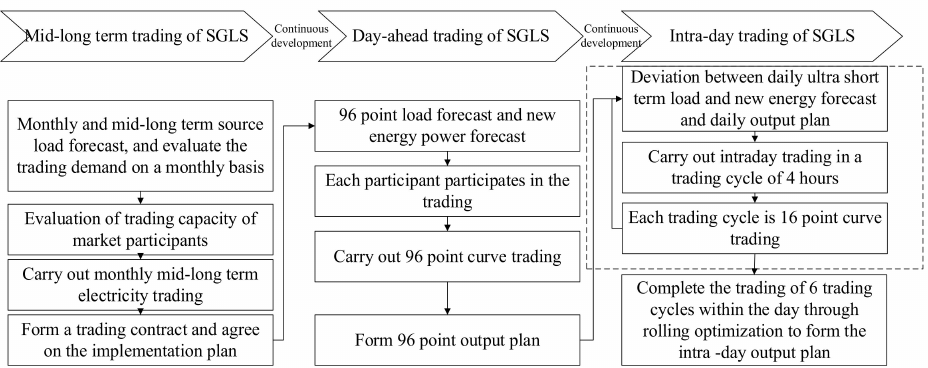
Figure 2. Continuous trading mechanism of monthly, day-ahead, and intra-day in